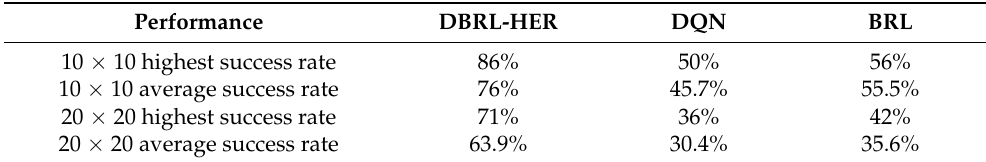
Table 1. Collision avoidance success rates of each algorithm.